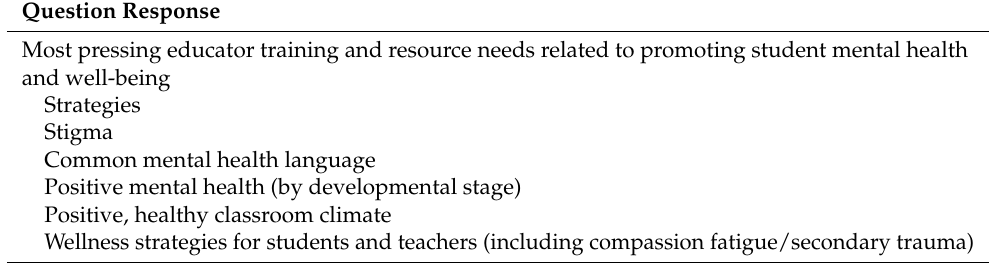
Table 3. Key informant interview